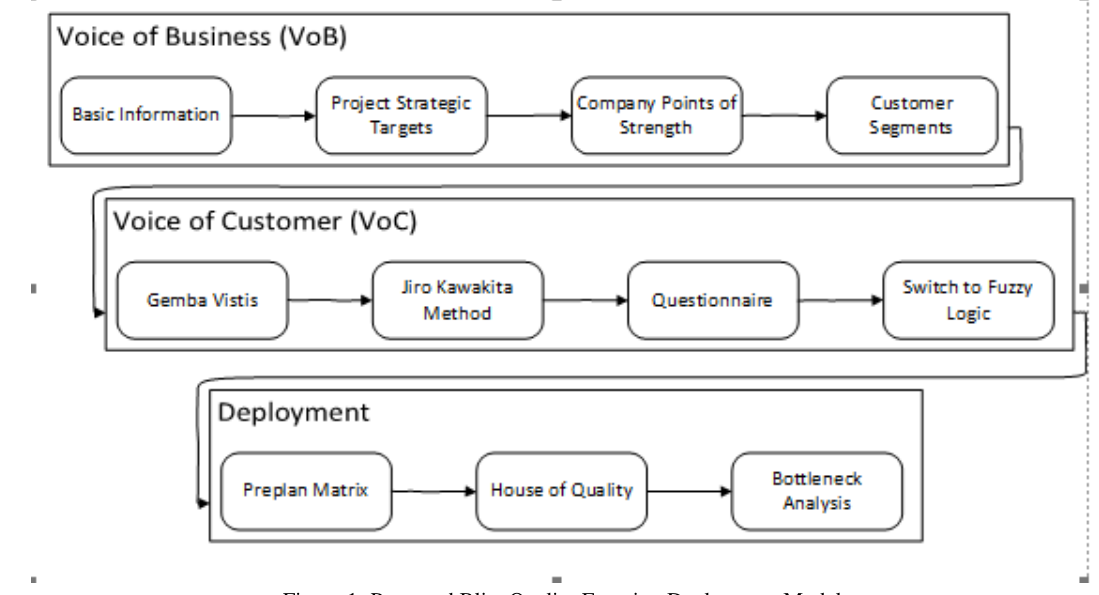
Figure 1. Proposed Blitz Quality Function Deployment